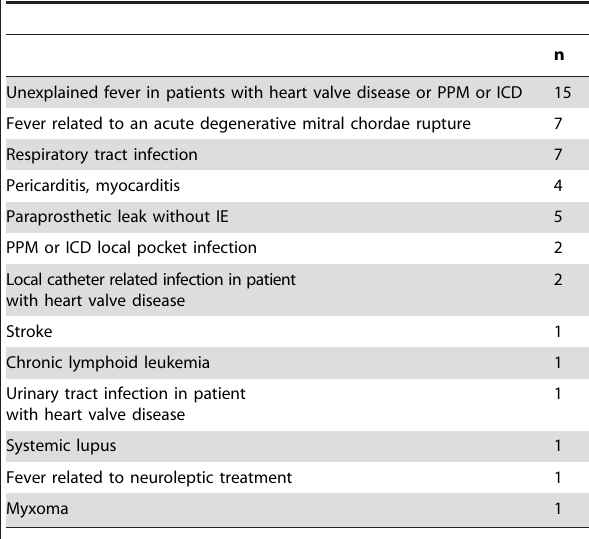
Table 2. Causes of hospitalization in the 48 controls.